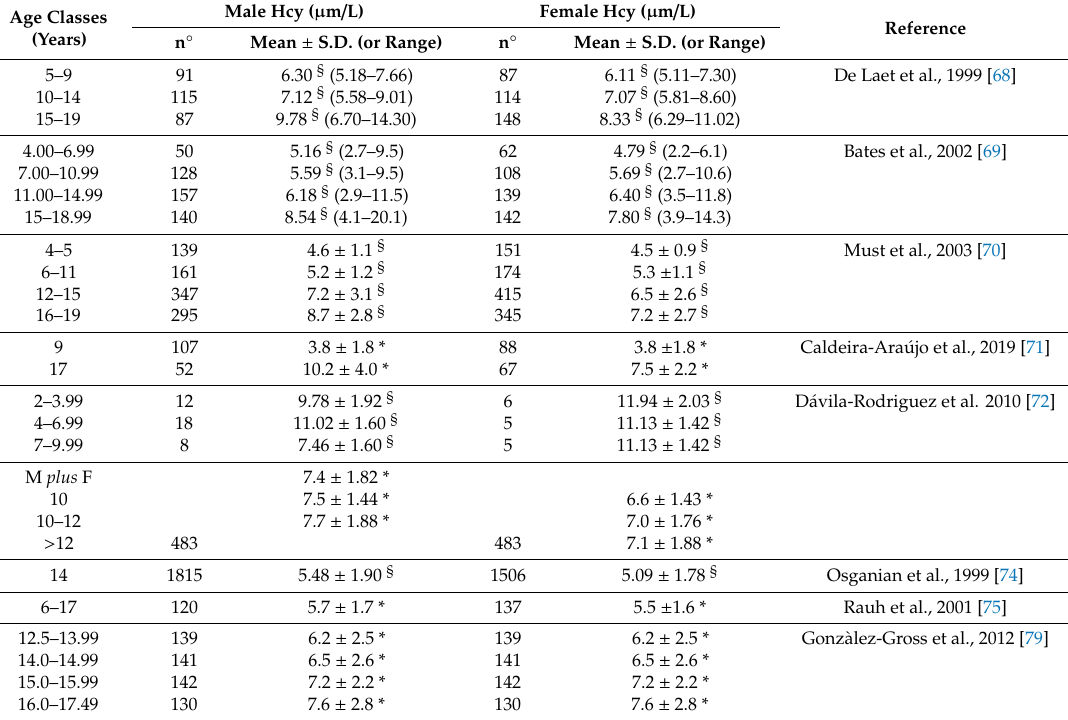
Table 1. Total Hcy levels in healthy children and adolescents in relation to age and